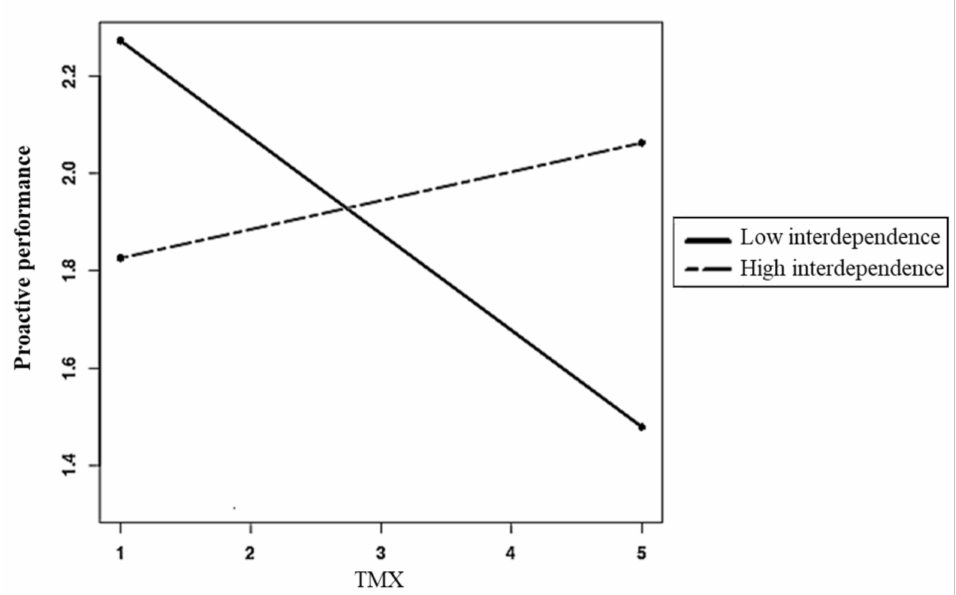
Figure 3. Proactive performance as a function of TMX at ± 1 standard deviation of task